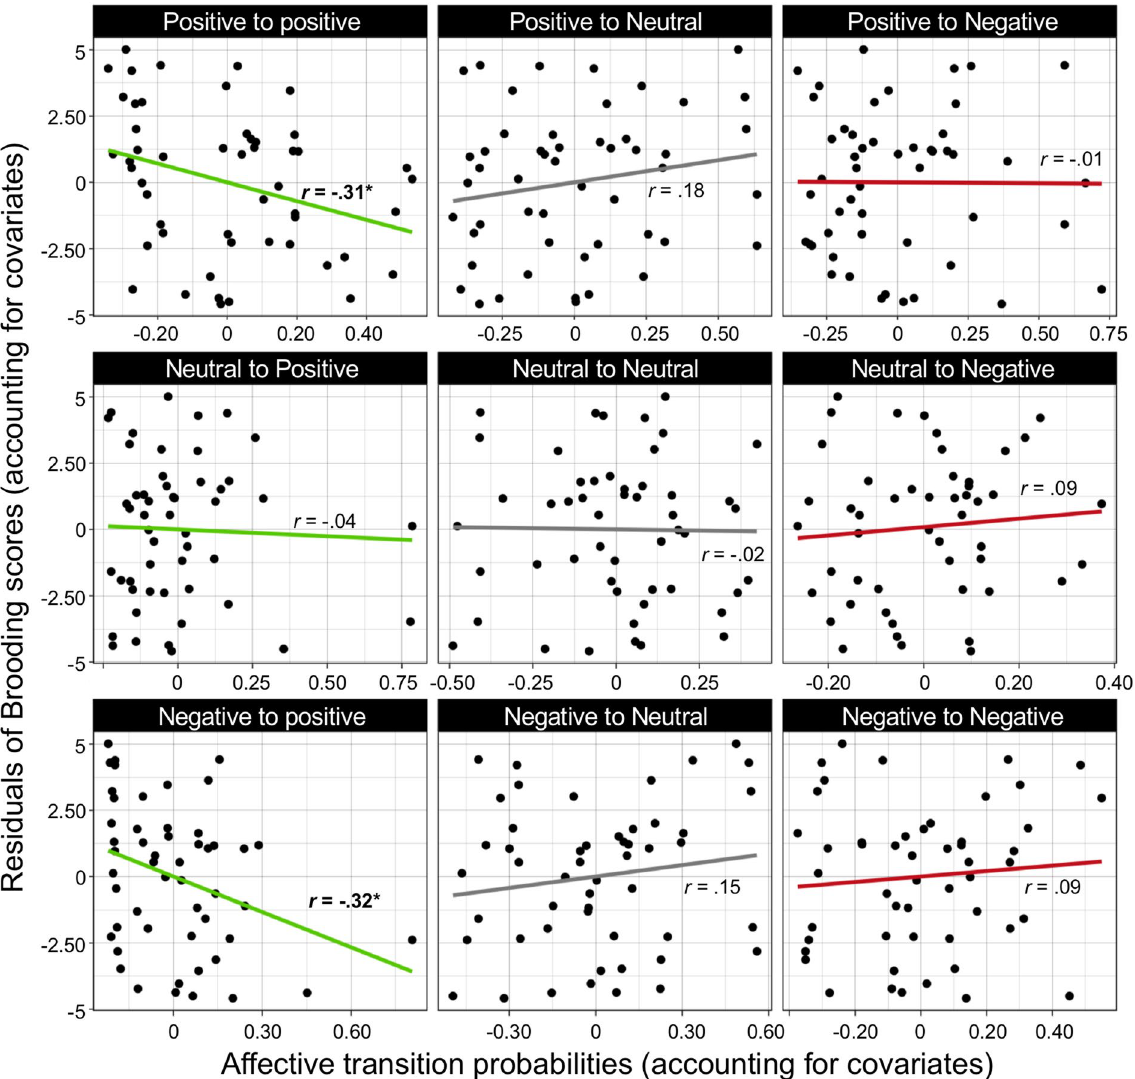
Figure 2. Linear relationships between affective transition probabilities and trait brooding. The probabilities of transitioning to a positive (green), neutral (grey), or negative (red) thought from current thoughts that are positive (top), neutral (middle), or negative (bottom) are examined in relationship to trait brooding. The y-axis reflects brooding once controlling for the covariates of censorship and daily thought similarity. * P <